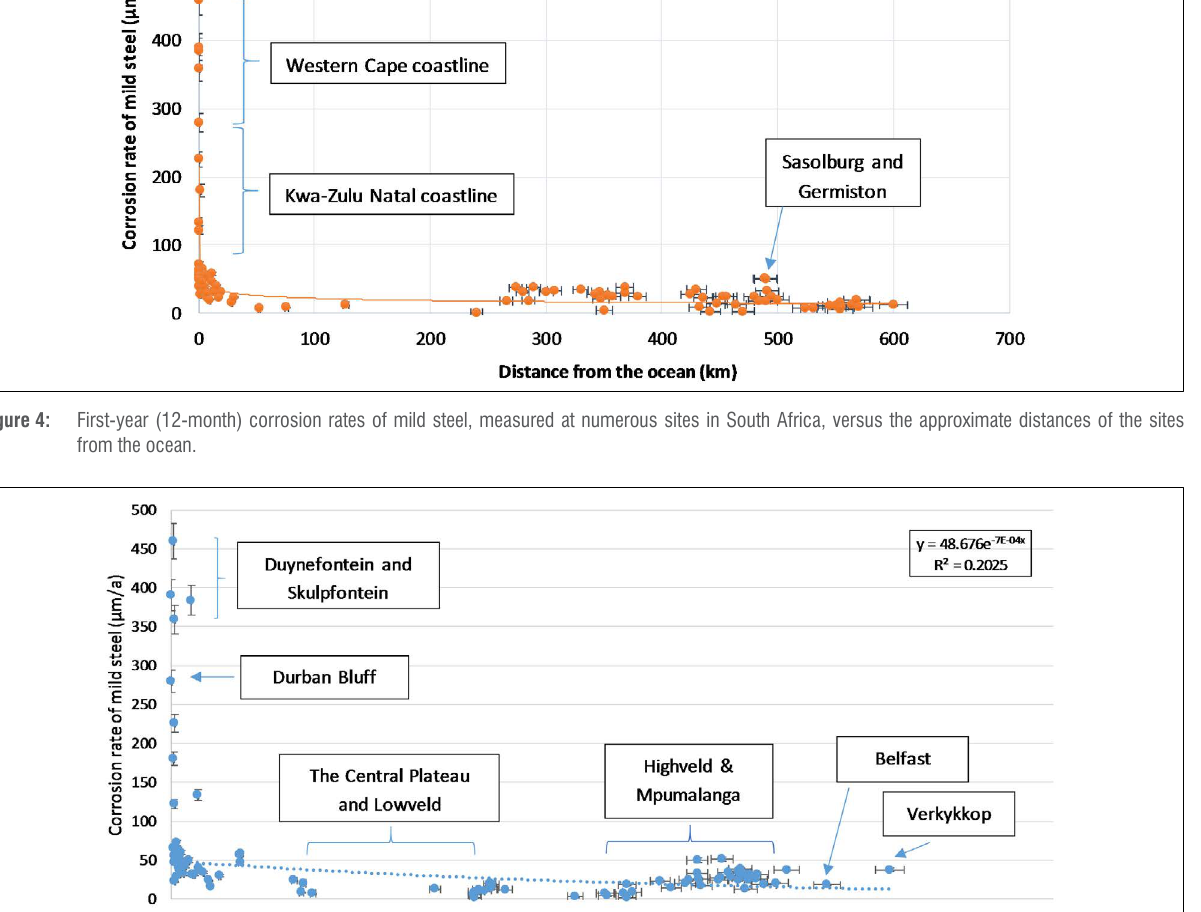
Research Article https://doi.org/10.17159/sajs.2019/4901